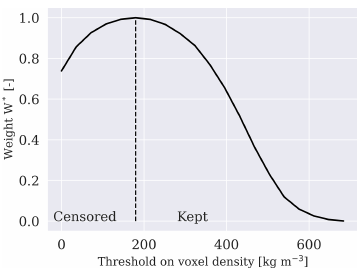
Figure A1. Example, for a reconstructed snowflake, of the distribu- tion of the weight W ∗ as a function of the threshold on the voxel density content ρ . The weight is displayed here as normalized be- tween 0 and 1. The threshold maximizing W ∗ is considered opti- mal, and it is used to censor the data to calculate geometric descrip- tors. A maximum could always be obtained for all the reconstructed